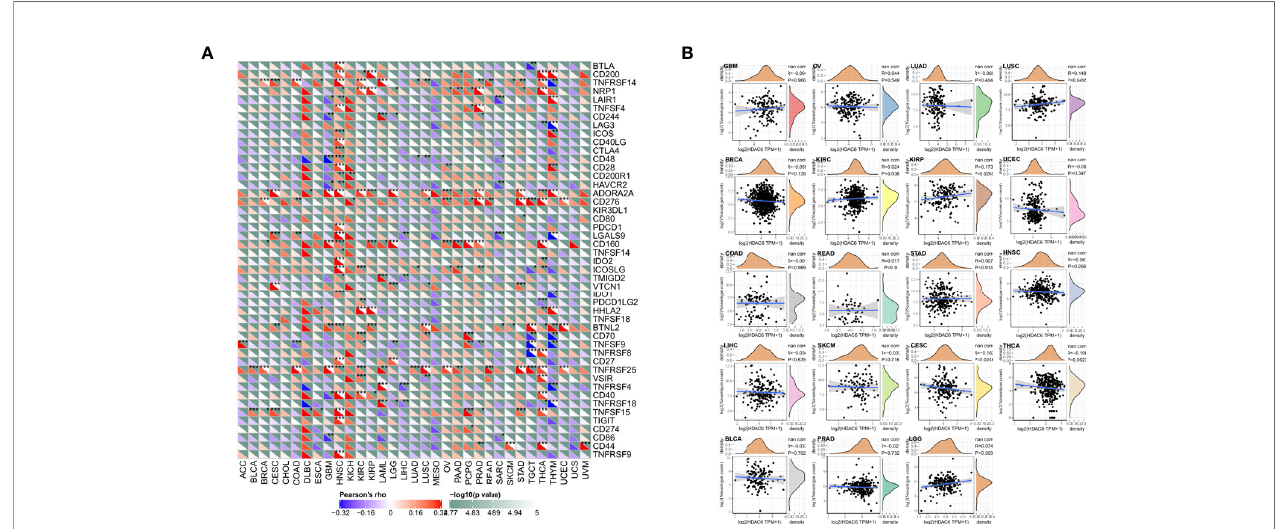
FIGURE 7 | Correlation analysis of HDAC6 expression levels with immune checkpoints and immune neoantigens. (A) Correlation analysis of HDAC6 expression levels with immune checkpoint gene expression levels in various tumors. (B) Correlation analysis of HDAC6 expression levels in various tumors with the number of neoantigens in tumors. * indicates correlation difference of P < 0.05, ** indicates correlation difference of P < 0.01, *** indicates correlation difference of P <